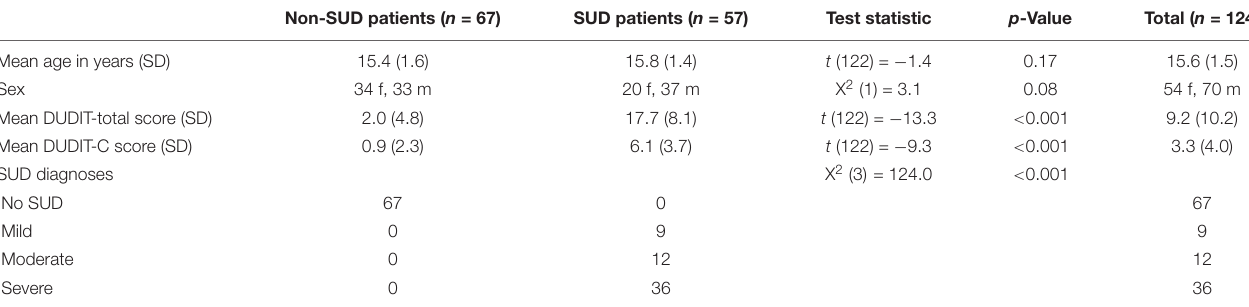
TABLE 1 | Sample description.